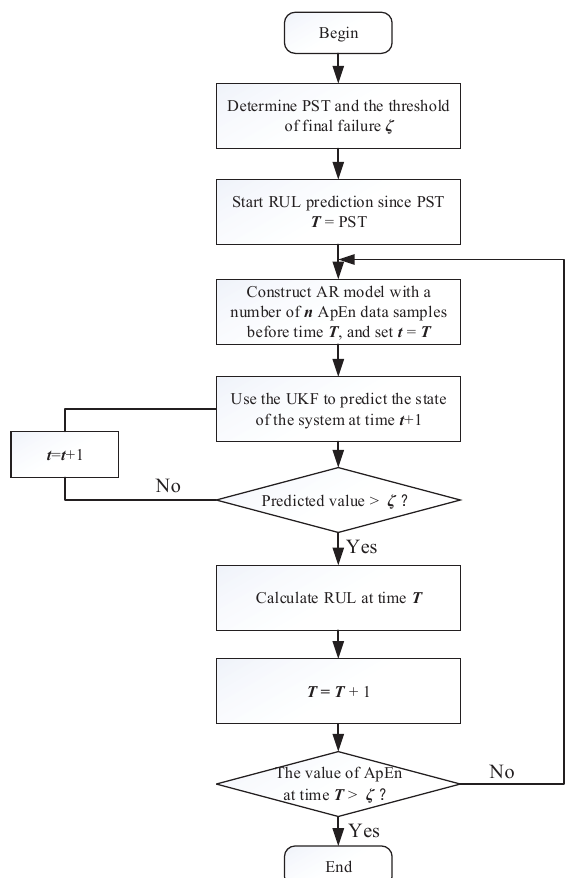
Figure 2. The flow diagram of RUL prediction based on Autoregressive (AR)-UKF model. PST = prediction starting